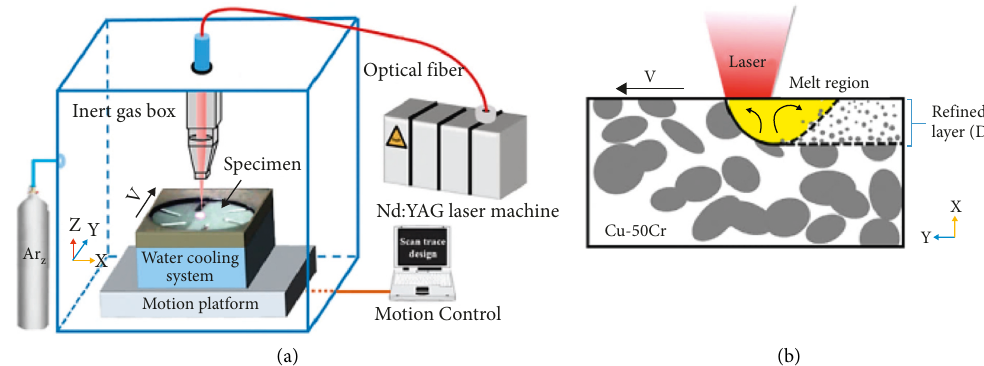
Figure 16: (a) Schematic diagram of experimental setup for LSM and (b) the principle diagram of interaction with Cu-Cr alloy [48].